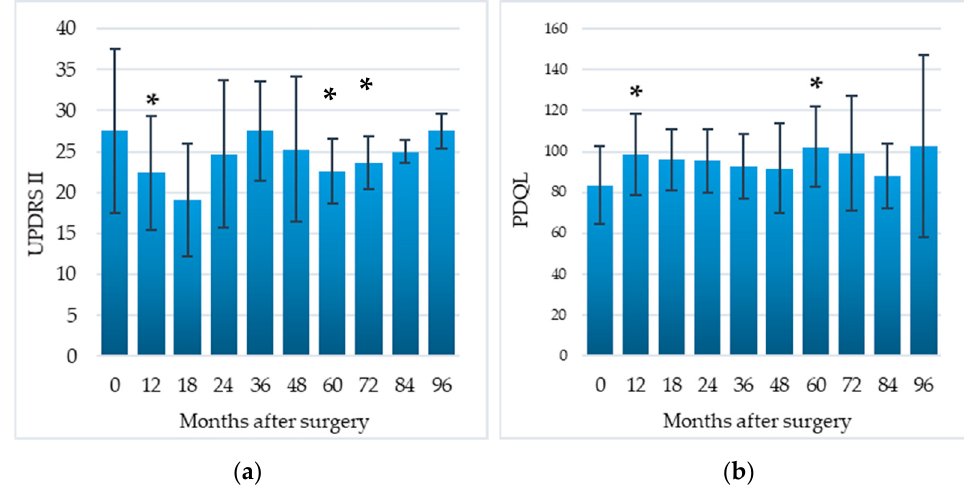
Figure 4. Impact of EMCS on daily living activities ( a ) and quality of life ( b ) in all patients, evaluated at different times after the implant. Error bars represent standard deviation. * p < 0.05 at comparisons between preoperative and postoperative scores, analyzed by means of the Wilcoxon signed-rank test.